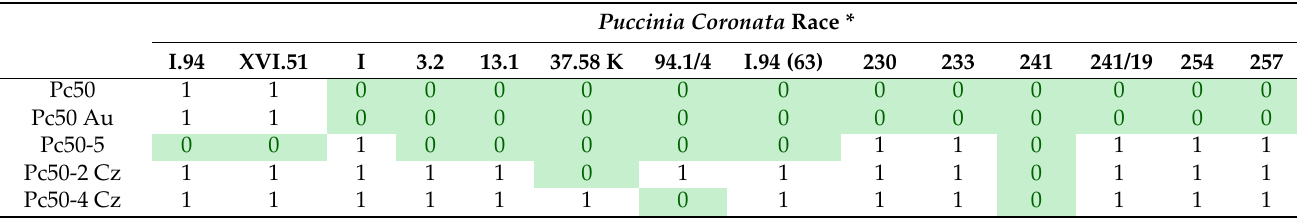
Table 1. Infection profiles of oat isolines derived from Pendek × CW 486-l crossing based on the reaction to P. coronata race infection.